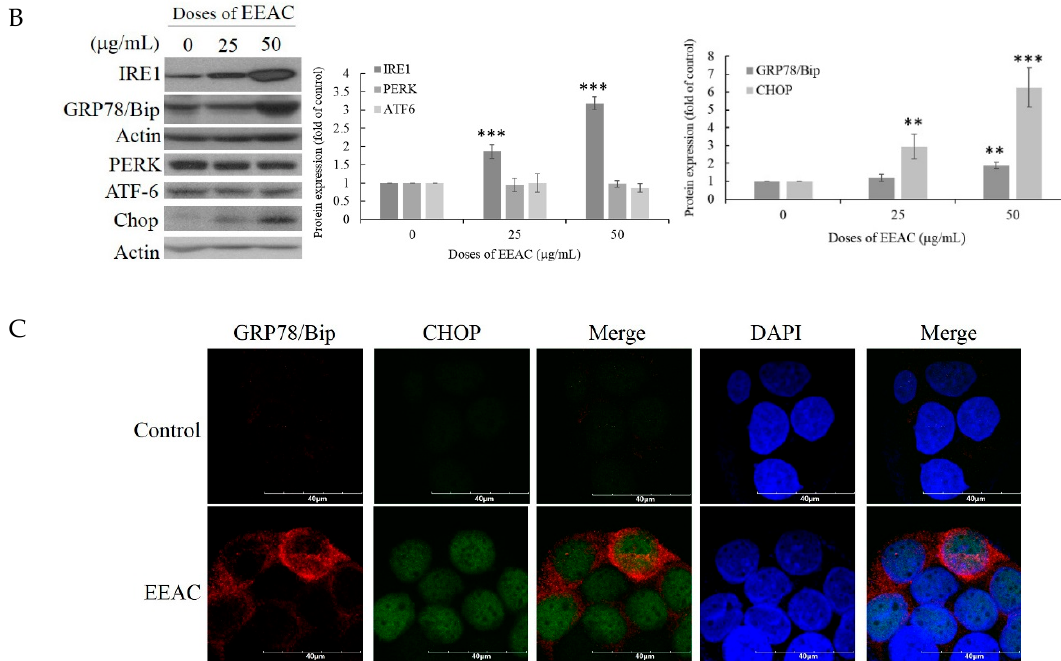
Figure 3. Effect of EEAC on endoplasmic-reticulum (ER). T47D cells were treated with EEAC (25 and 50 µ g/mL) for 48 h. ( A ) Cells were collected and stained with Fluo-3 AM for the determination of Ca 2+ concentration and analyzed using flow cytometry. ( B ) Expression of ER stress sensor proteins IRE1 (inositol-requiring enzyme 1 α ), PERK (pancreatic endoplasmic reticulum kinase), and ATF-6 (activating transcription factor 6), as well as ER stress marker GRP78/Bip and CCAAT-enhancer-binding protein homologous protein (CHOP), was determined by Western blot assay. Actin was used as the loading control. ( C ) Confocal microscopy image of GRP78/Bip (red) and CHOP (green) stained T47D cells were treated with EEAC (50 µ g/mL) for 48 h. Cells were counterstained with DAPI to label cells nuclei (blue). All the results are presented as mean ± SD of at least three experiments, ** p < 0.01; *** p < 0.001.